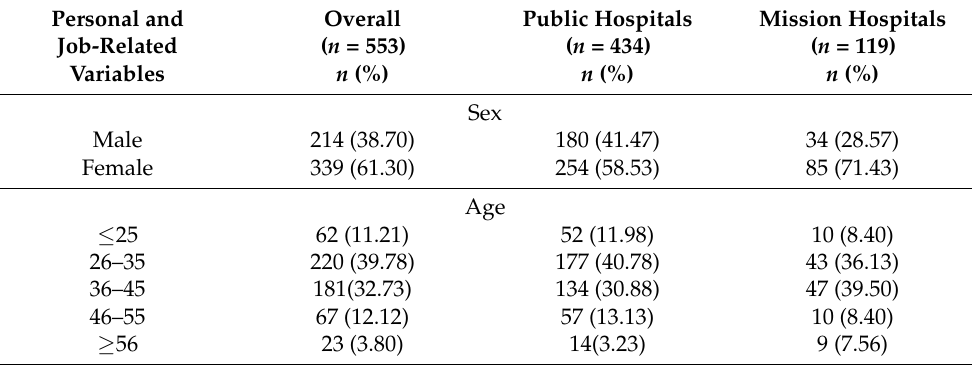
Table 1. Overall and sub-sample percentage frequency distributions of personal and job-related